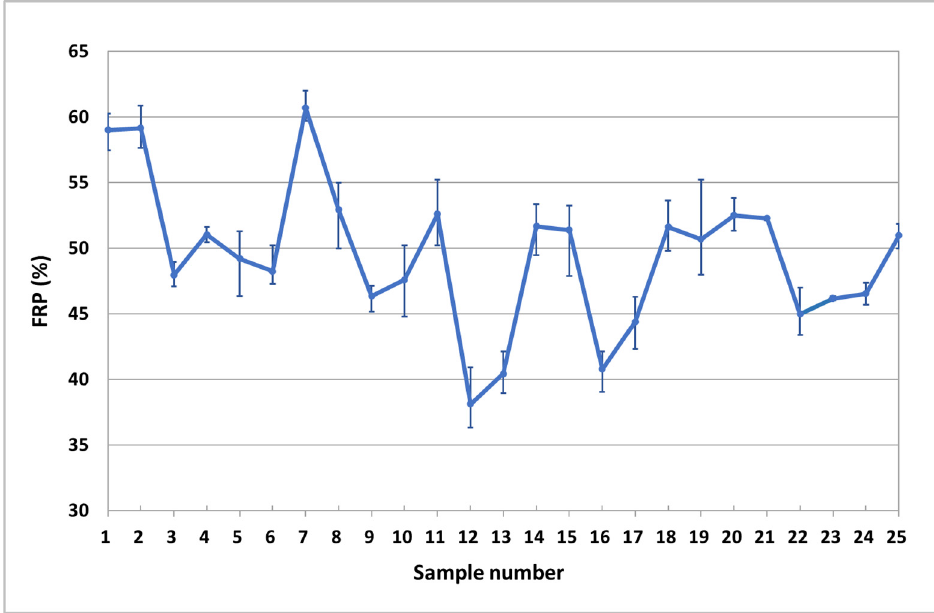
Figure 2. Variation of the FRP value in function of the composition of the alloys.